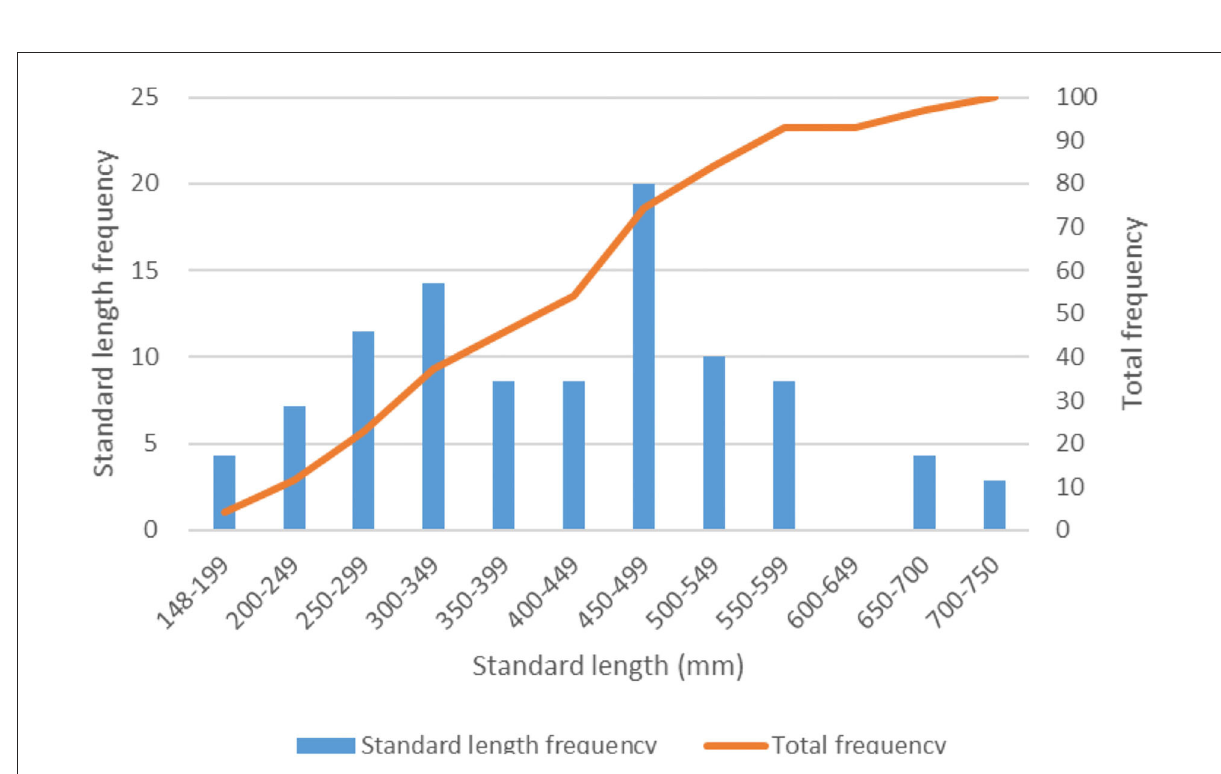
FIGURE6 Estimated standard lengths of Chinese sea bass of Guye site, N =